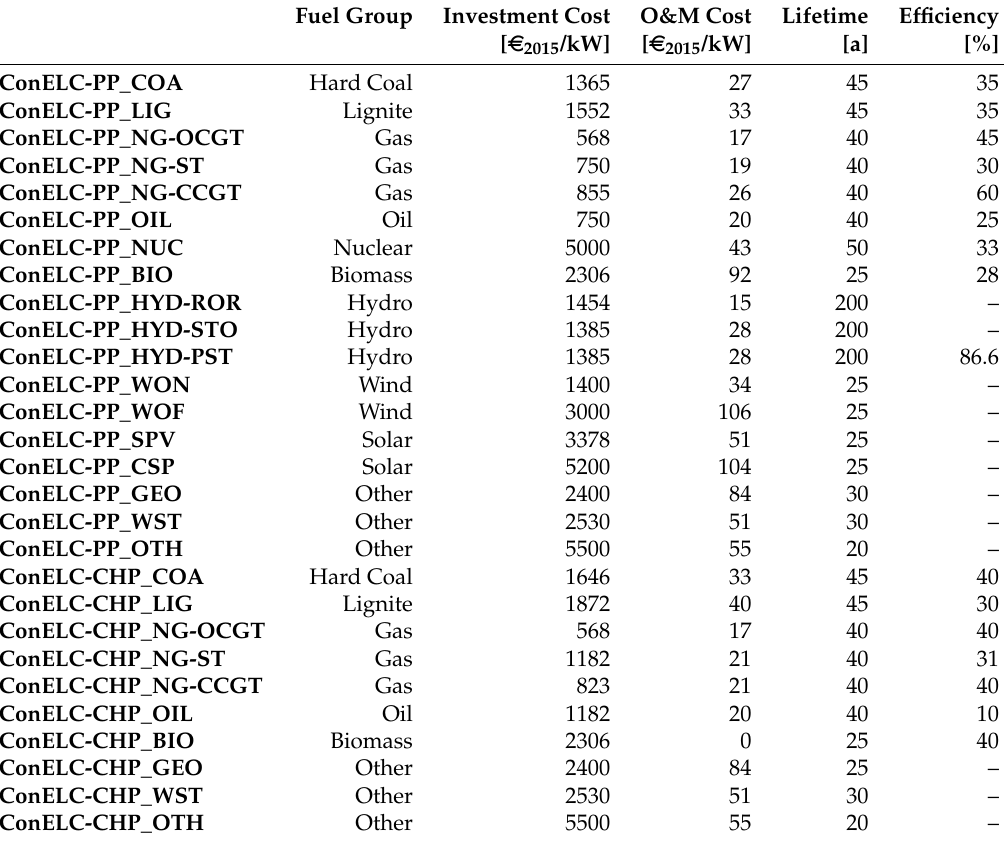
Table A6. Techno-economic parameters which are used as model input data for all scenarios.